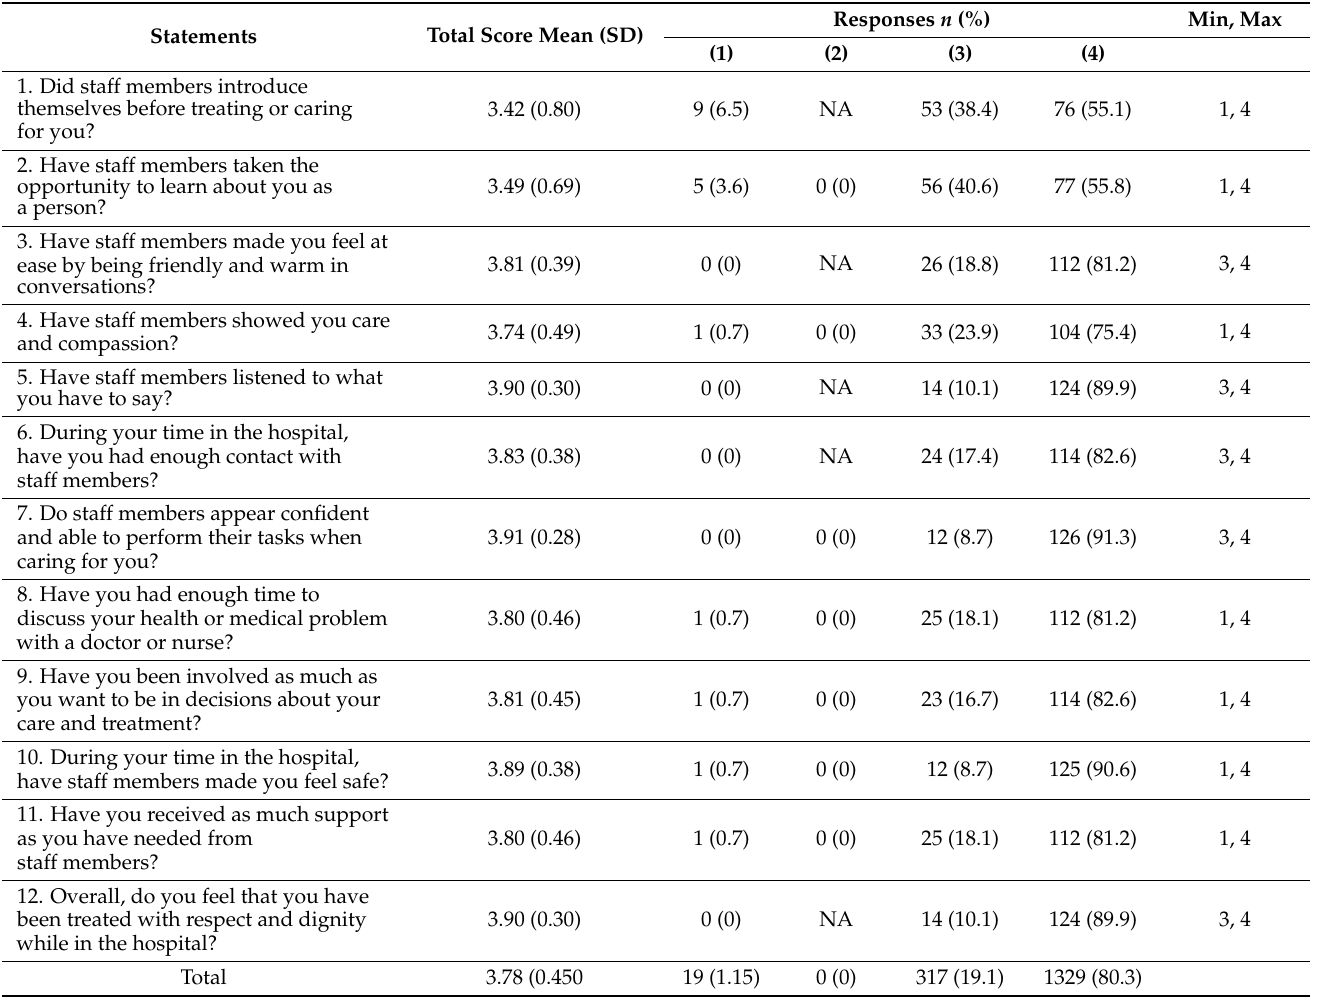
Table 3. Responses to the questionnaire ( n =